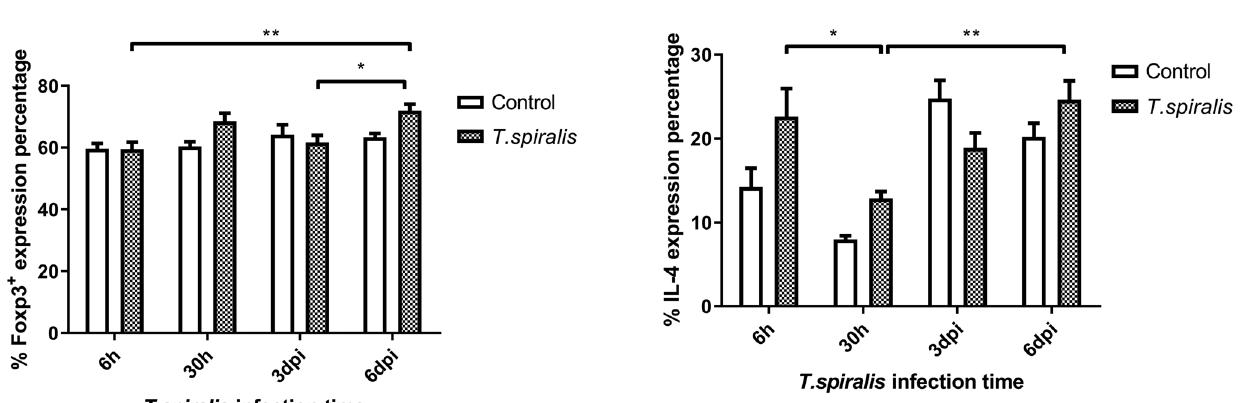
Figure 7. Percentage and expression of IL-4 of Th2 cells in mice infected with 250 muscle larvae of Trichinella spiralis compared to uninfected (control) mice from 6 h to 6 dpi. * p < 0.05 and ** p < 0.01 indicating a statistically signi fi cant